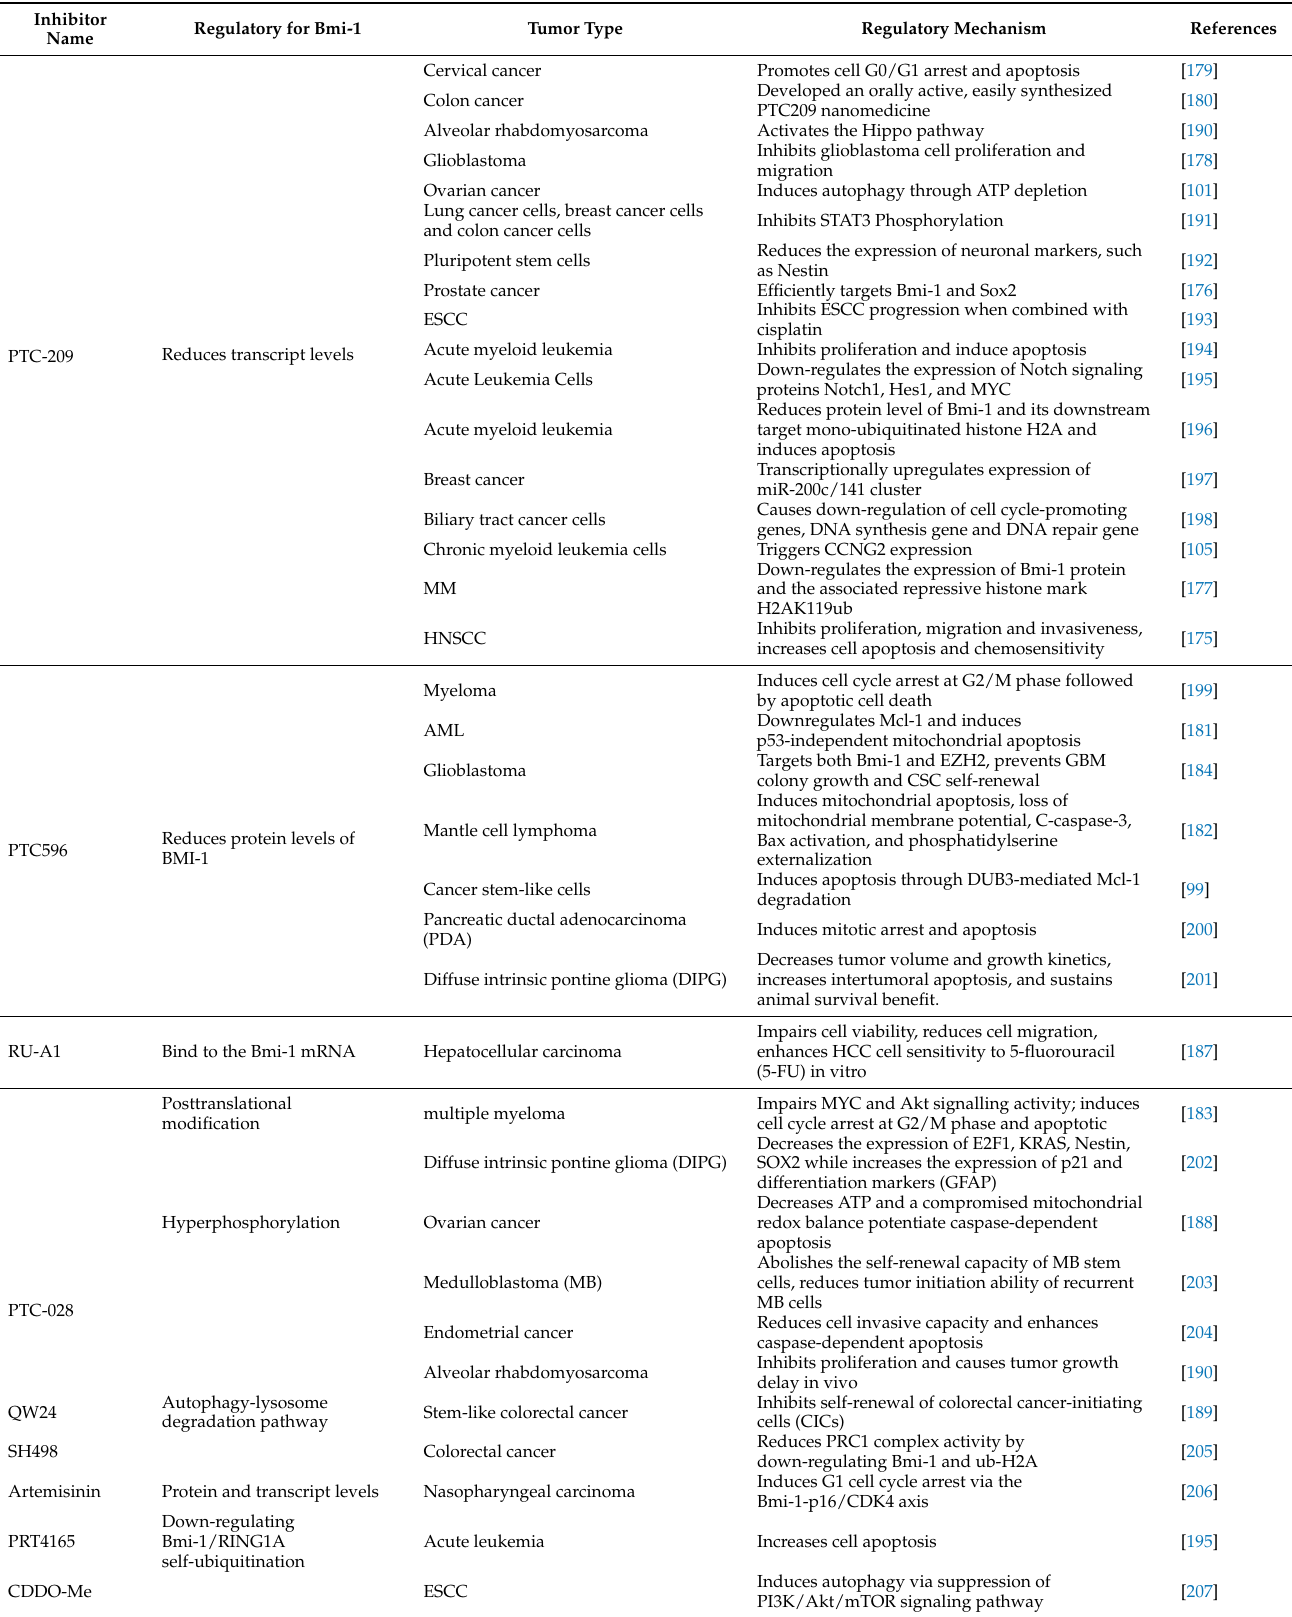
Table 3. Inhibitors of